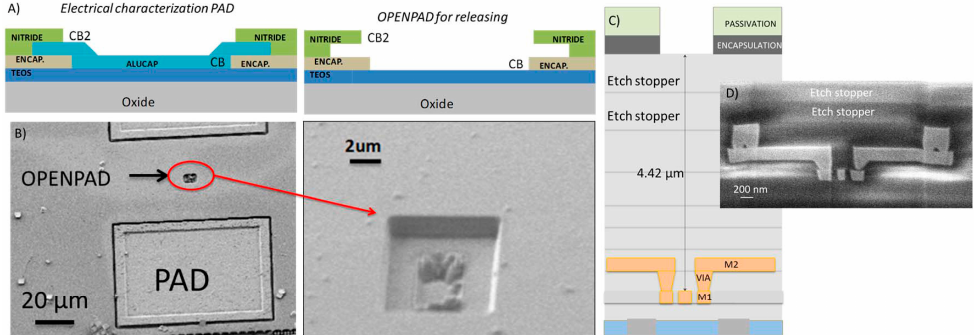
Figure 1. ( A ) Schematic of the electrical pad (PAD in figure) and open pad (OPENPAD in figure) configuration. ( B ) Scanning electronic microscope (SEM) image of an electrical PAD and OPENPAD (with additional zoomed SEM image) before the releasing process. ( C ) Schematic cross section of the CMOS technology showing OPENPAD, etch stoppers layers in the BEOL metal layers and M1 NEMS structure with M2 anchors before the releasing process. ( D ) SEM image of a field ion beam cross section of a M1-M2 NEMS structure before the releasing